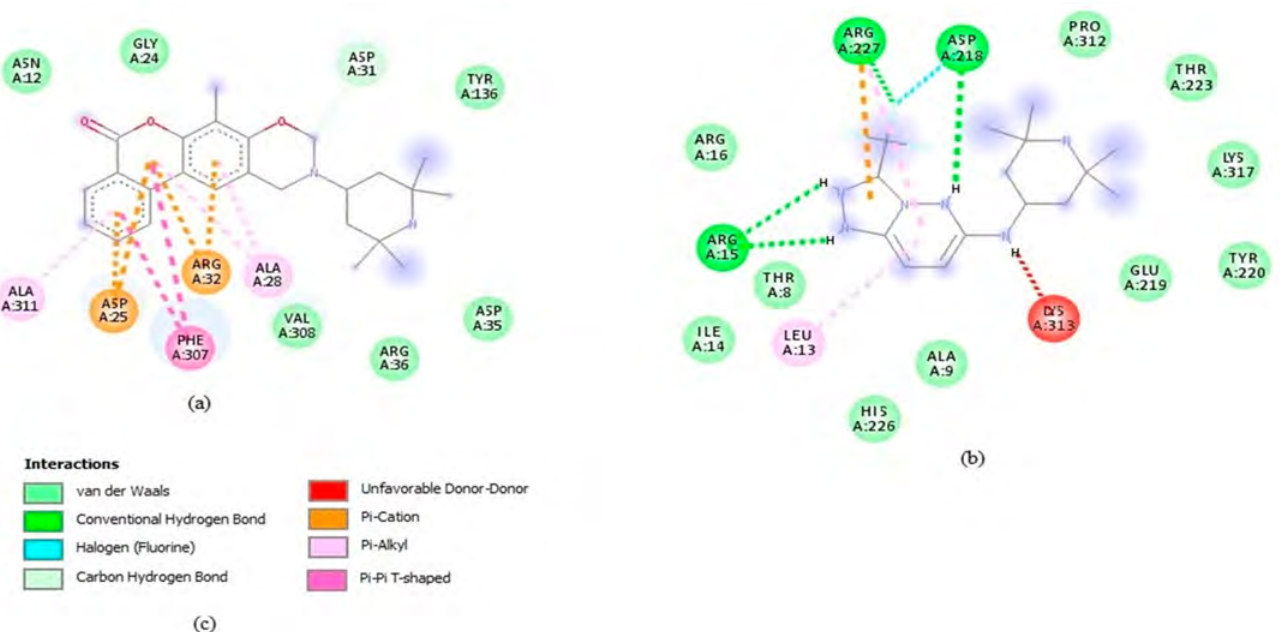
Figure 5. Two-dimensional interactions of the Ld SMT-hit complexes as visualised in Discovery Studio v.19.1.0.18287 [42]. ( a ) Ld SMT-STOCK6S-06707 complex, ( b ) Ld SMT-STOCK6S-84928 complex, and ( c ) legend of